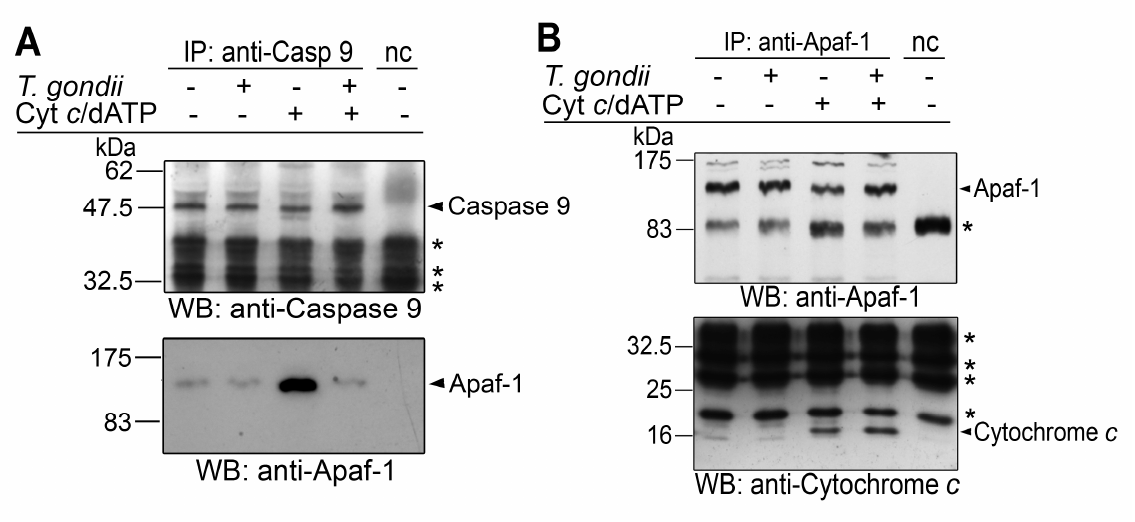
FIGURE 4: Interference of T. gondii with holo-apoptosome assembly as revealed by co-immunoprecipitation analyses. (A, B) Cell-free cyto- solic extracts from Jurkat cells were incubated or not with T. gondii (10 8 /ml). After 1 hour, apoptosome formation was triggered by addition of cytochrome c and dATP as indicated. Caspase 9 (A) or Apaf-1 (B) was immunoprecipitated using specific antibodies and protein A- sepharose in the presence of a caspase 3-inhibitor. A negative control precipitation without cell lysate was run in parallel (nc). Precipitates were resolved by SDS-PAGE and were analyzed by immunoblotting using specific antibodies as indicated. Bound antibodies were visualized by enhanced chemiluminescence after incubation with appropriate peroxidase-conjugated secondary antibodies. Unspecific binding of sec- ondary antibodies is indicated by asterisks. The experiment was repeated twice with similar